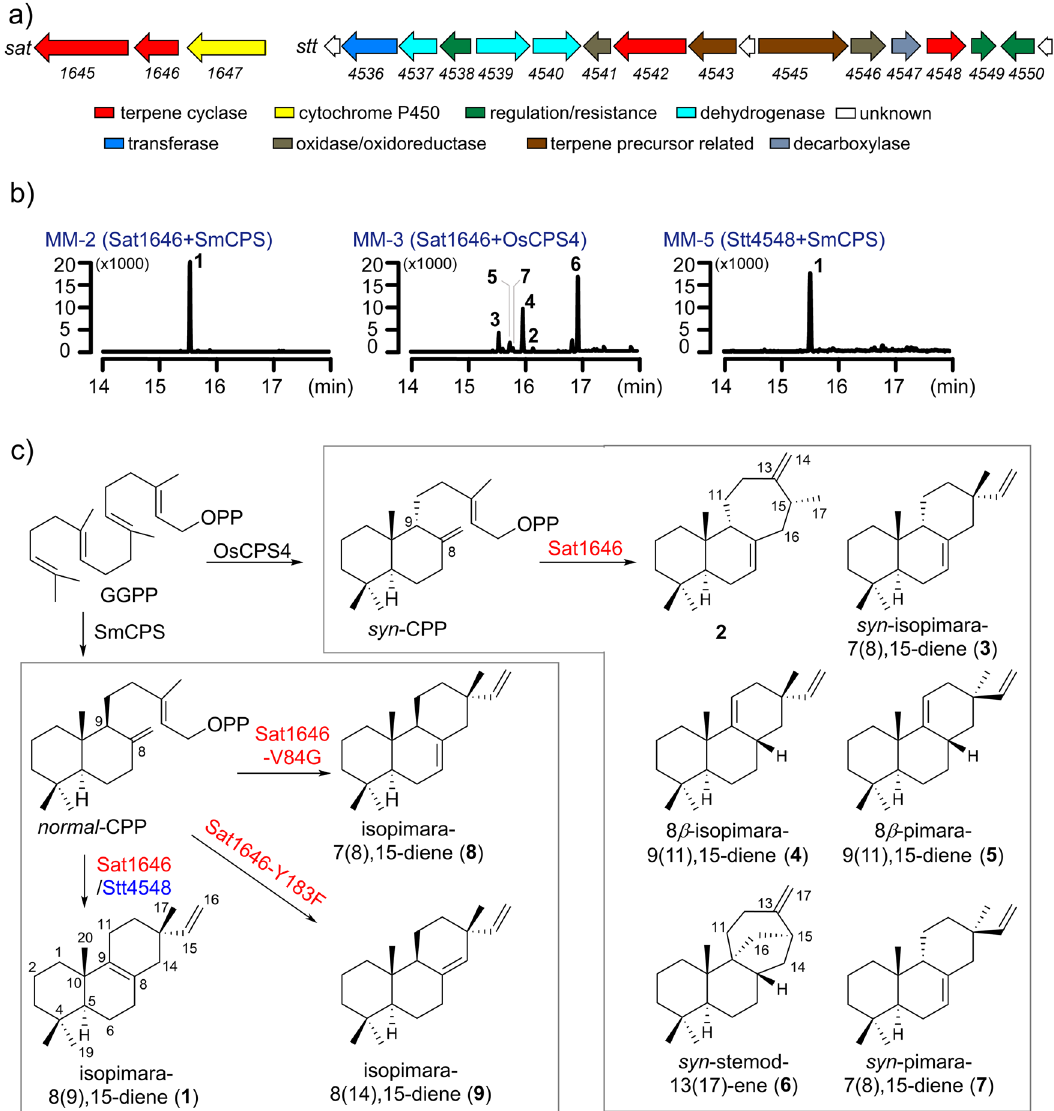
Fig. 1 The two diterpenoid biosynthetic gene clusters ( sat and stt ), the GC-MS analysis of different engineered E. coli strains, and the conversion from normal -CPP (designated CPP in this study) and syn -CPP to diterpenes 1 – 9 catalyzed by Sat1646, Sat1646 mutants or Stt4548. a The sat and